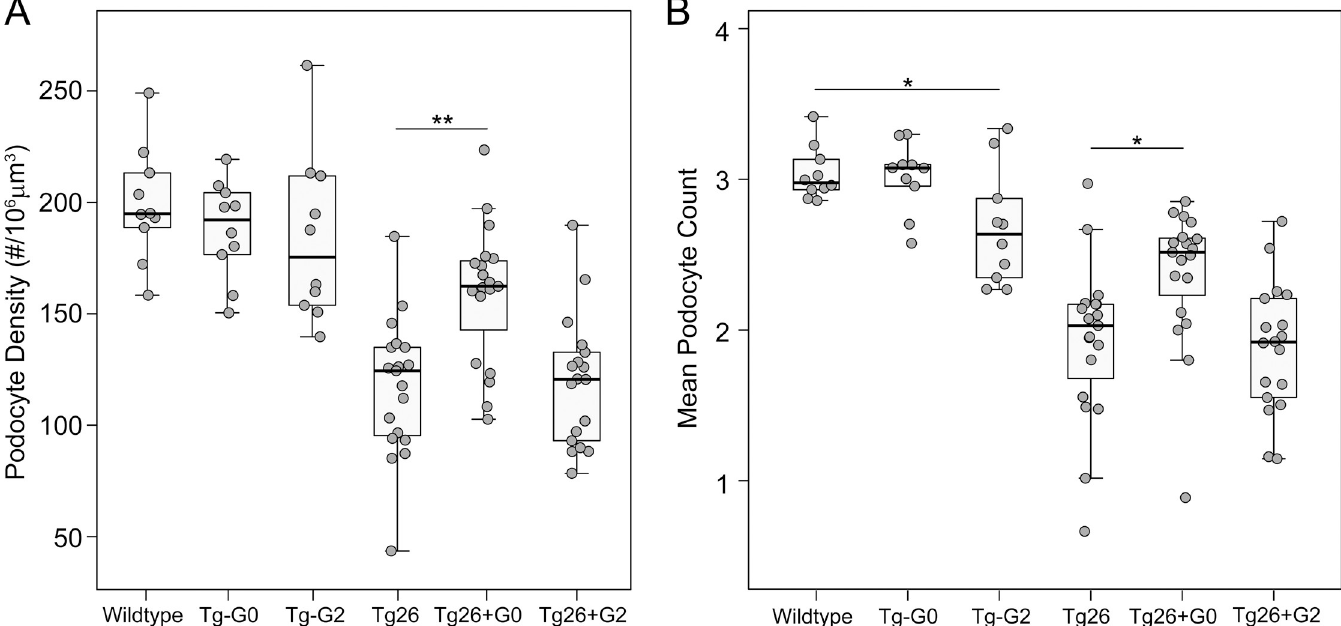
Fig 2. APOL1-G0 preserves podocyte density in a murine model of HIVAN. A . Mean podocyte densities calculated from podocyte counts (panel B) and glomerular volumes (S2 Fig). B . Mean podocyte number per glomeruli. Each data point represents one mouse, boxes are interquartile range, whiskers are 95% confidence intervals. Numbers in each group were: Non-transgenic (wild-type) n = 10, Tg26 n = 19, Tg26+G0 n = 19, Tg26+G2 n = 18, Tg-G0 n = 10, Tg-G2 n = 10. Statistical comparisons were made to the relevant non- APOL1 expressing group (Tg-G0 or Tg-G2 versus wildtype, and Tg26+G0 or Tg26+G2 versus Tg26; � P < 0.05, �� P < 0.01).